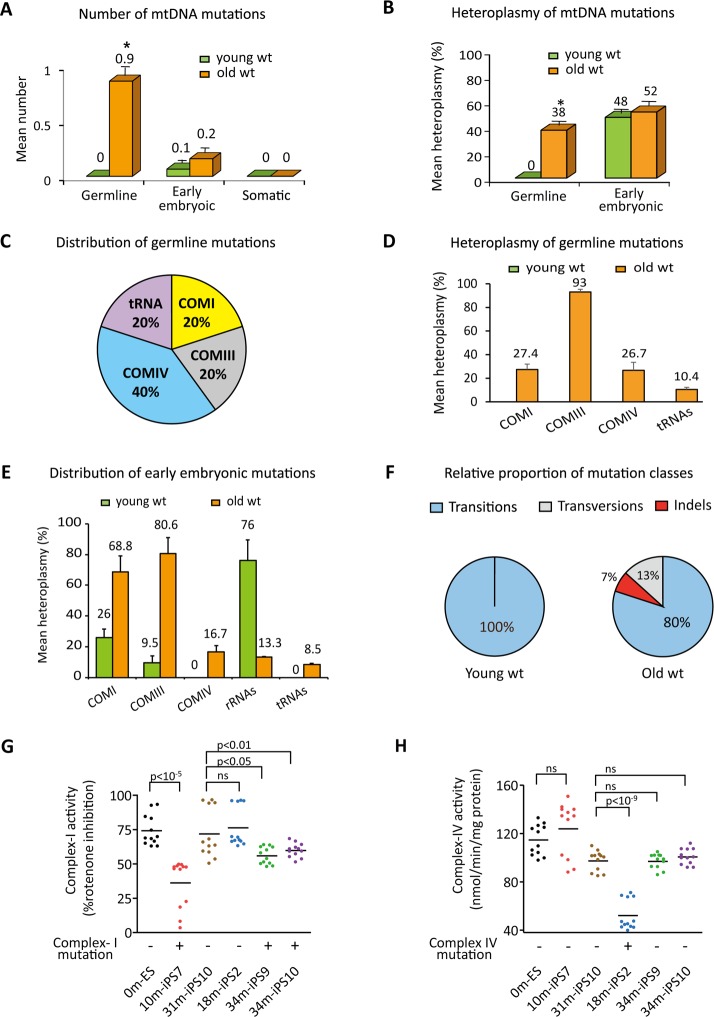
Characterization of mtDNA mutations in wild type mice with aging.(A) Quantification of mtDNA mutations (mean ± SEM; asterisk, P < 0.05, Student’s t-test) for different mutation types in young wt mice at age 2–13 months (green bars; n = 31) and old mice at age 18–34 months (orange bars; n = 44). Somatic mutations were undetectable in wt mice. Asterisk represents a significant increase in number of germline mutations with age. (B) Mean heteroplasmy levels of non-synonymous germline and early embryonic mutations as a function of age. Error bars, mean ± SEM. Asterisk represents a significant increase in the mean heteroplasmy levels of non-synonymous germline mutations in old wt mice compared to the young group (P < 0.05, Student’s t-test). (C) Pie chart showing gene distribution of non-synonymous germline mutations in protein-coding and RNA coding genes in old wt mice. (D) Bar graphs showing mean heteroplasmy levels for non-synonymous germline mutations in protein-coding and RNA-coding genes in old wt mice. (E) Heteroplasmy of non-synonymous mutations in protein-coding and RNA-coding genes of early embryonic origin. (F) Pie chart showing relative proportion of mutation types in young and old wt mice. (G) Mitochondrial OXPHOS complex I activity in iPS cells carrying non-synonymous mutations in protein-coding genes and in age-matched control ESCs or iPS cells. The complex I activity was measured in cell homogenates (n = 12 per cell line, technical replicates) and was expressed as “% rotenone inhibition”. 10m-iPS7, 34m-iPS9 and 34m-iPS10 cells displayed reduced activities compared to controls. (H) Mitochondrial OXPHOS complex IV activity in iPS cells carrying non-synonymous mutations in protein-coding genes and in age-matched control ES or iPS cells. The complex IV activity was measured in cell homogenates (n = 12 per cell line, technical replicates) and was expressed as “nmol / min / mg protein”. 18m-iPS2 cells showed decreased activity compared to controls. In (G and H), ns denotes p ≥ 0.05.